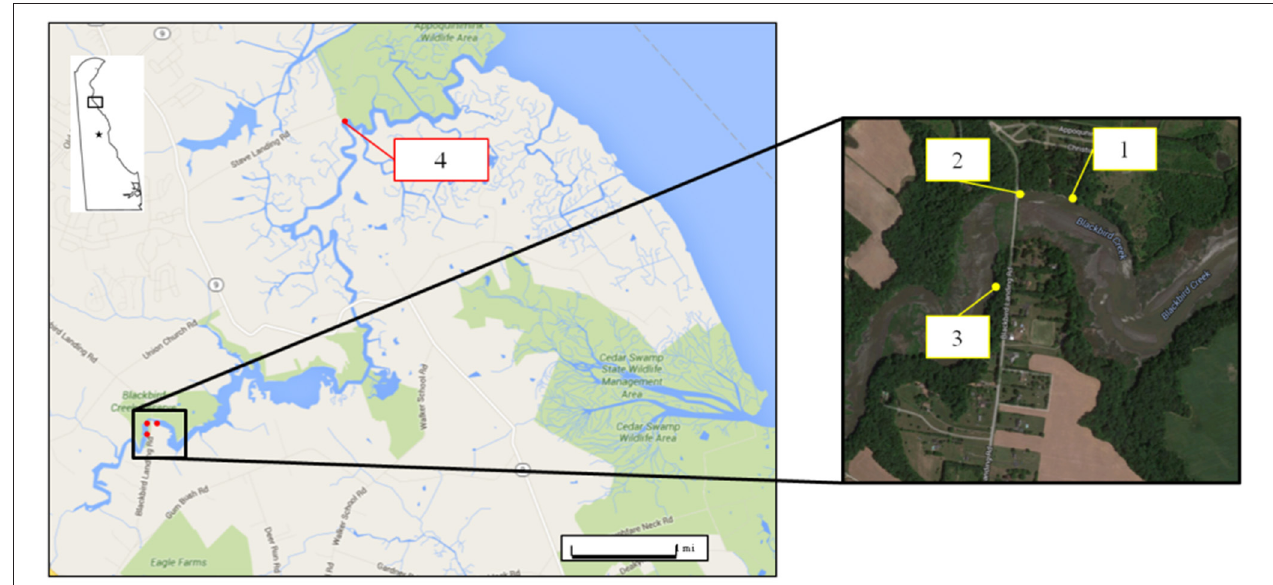
FIGURE 1 | Geographical location of the sample collection points from the upstream (sites 1, 2, 3) and downstream (site 4) sites in Blackbird Creek,